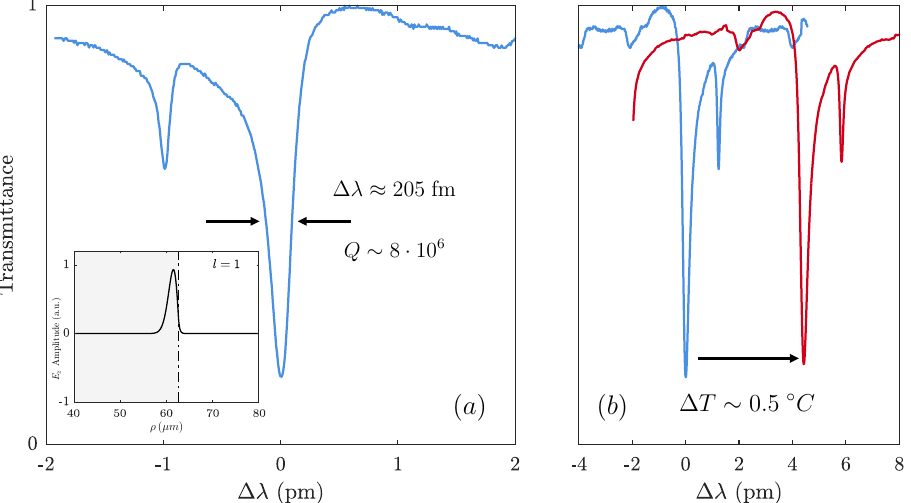
Figure 3. ( a ) Transmission trace of a typical WGM resonance (inset: radial profile of a fundamental mode of a WGM resonance ( l = 1 and m = 354); ( b ) illustrative example of the wavelength shift suffered by the resonances for a temperature increment of ∆ T = 0.5 ◦